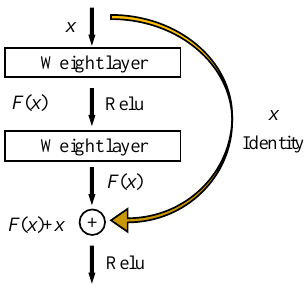
Figure 8. Structure of the residual